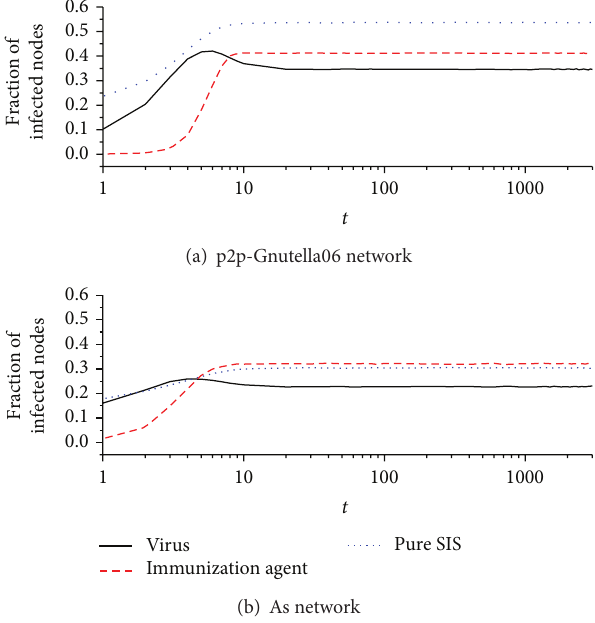
Figure 5: The fraction of infected nodes of the virus spread, immunizationagentspread,andpureSISspreadasfunctionsoftime 𝑡 , respectively, on different real-world networks. (a) p2p-Gnutella06 network and (b) AS network. Their effective transmission rates are all 0.4. The recovery rate of the virus spread 𝛽 (1) = 0.25, the recovery rate of the immunization agent spread 𝛽 (2) =